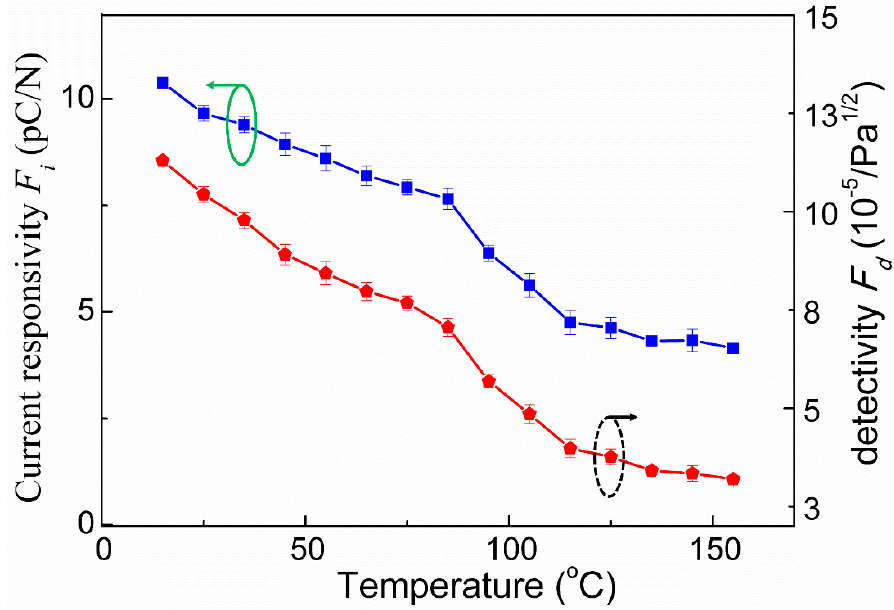
Figure 3. Variation of FOMs as a function of temperature for BZBO crystals . In view of the good pyroelectric performance of BZBO crystals, the orientation depen- dence of the pyroelectric coefficient was discussed in accordance with coordinate rotation. around the X -axis. It can be observed that when the angles were 0 ◦ , 90 ◦ , 180 ◦ , 270 ◦ and 360 ◦ , the p i reached the maximum, being on the order of 6.41 µ C/(m 2 · ◦ C). stable at the measured temperature range, which makes BZBO a promising candidate for